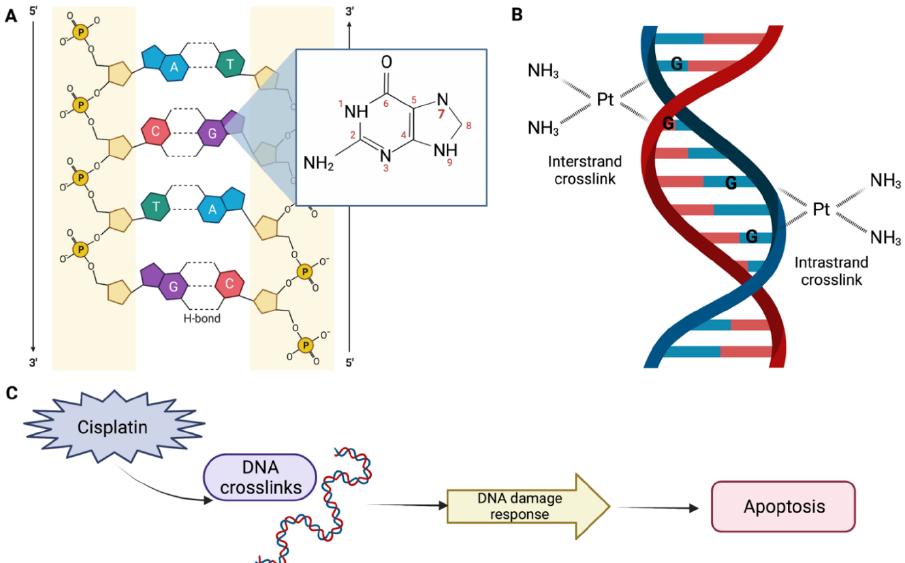
Figure 1. Mechanism of the cisplatin (DDP) action. ( A ) The platinum atom of DDP binds covalently to the N7 position of guanine. ( B ) An interstrand crosslink is formed when DDP binds to two bases from different strands. On the other hand, an intrastrand adduct is formed when DDP binds to two bases of the same strand. ( C ) DDP perturbs genomic DNA, inducing DNA damage response, which may result in apoptosis, DNA repair, and/or cell cycle arrest. Created with BioRender.com. The nephrotoxic effect produced by DDP is due to it accumulation in the kidney, mainly in the S3 segment of the proximal tubules, determined by the high density of neg- atively charged mitochondria in the proximal tubular cells, which attracts positively injury of kidney tubules and the consequent loss of renal function.